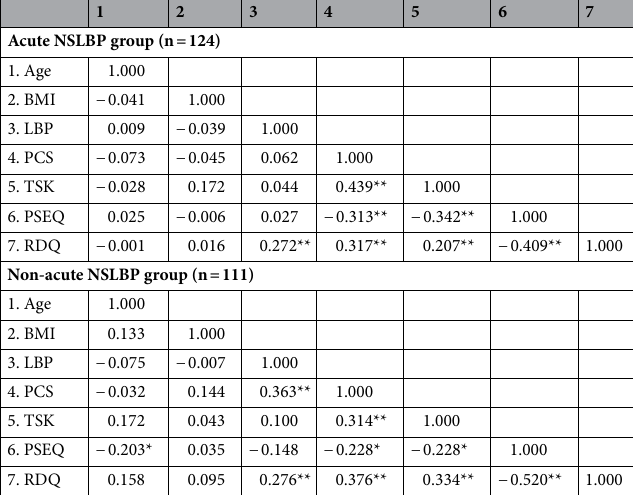
Table 3. A matrix of the correlations. *p < 0.05, **p < 0.01. NSLBP non-specific low back pain, LBP low back pain, BMI Body Mass Index, PCS Pain Catastrophizing Scale, TSK Tampa Scale for Kinesiophobia, PESQ Pain Self Efficacy Questionnaire, RMDQ Roland Morris Disability Questionnaire.